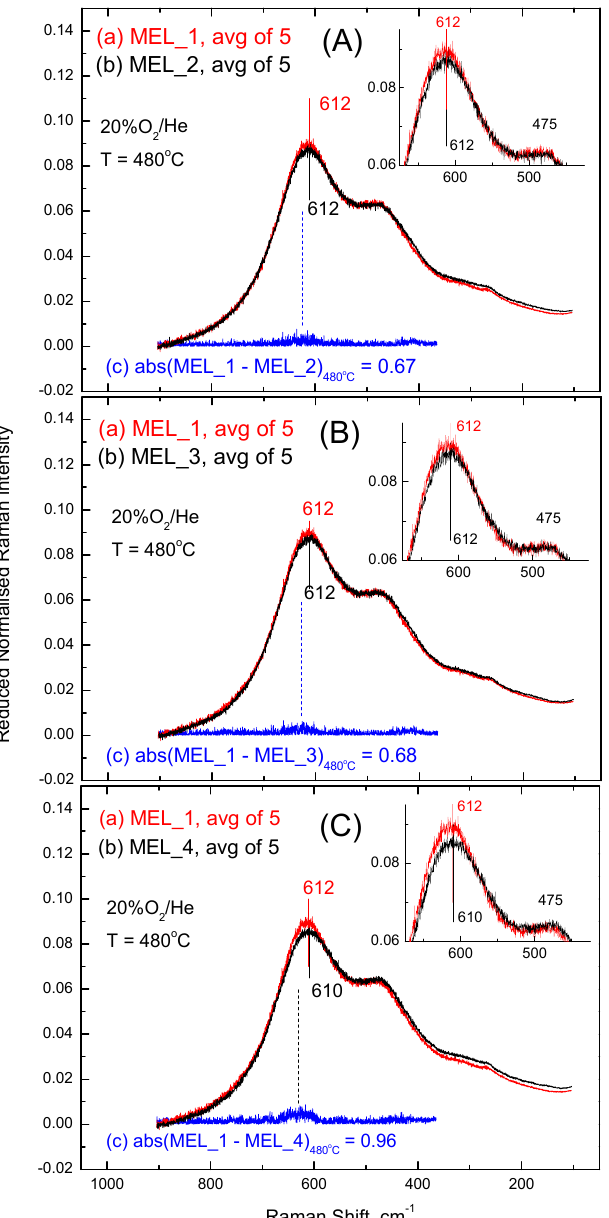
Figure 5. Comparative plots of reduced and normalized in situ Raman spectra obtained under 20% O 2 / He at 480 ◦ C. ( A ) MEL_2 vs. MEL_1; ( B ) MEL_3 vs. MEL_1; ( C ) MEL_4 vs. MEL_1. Traces (a) pertain to MEL_1; traces (b) pertain to MEL_ i ( i = 2, 3, 4) as indicated in each panel. Traces (a) and (b) are the averages of five recordings. Traces (c) with blue color in panels ( A – C ) show the absolute di ff erence of traces (a) and (b) under comparison in each case and the 0.67, 0.68, and 0.96 values correspond to the integrals under each trace (c). Recording parameters, see Figure 1